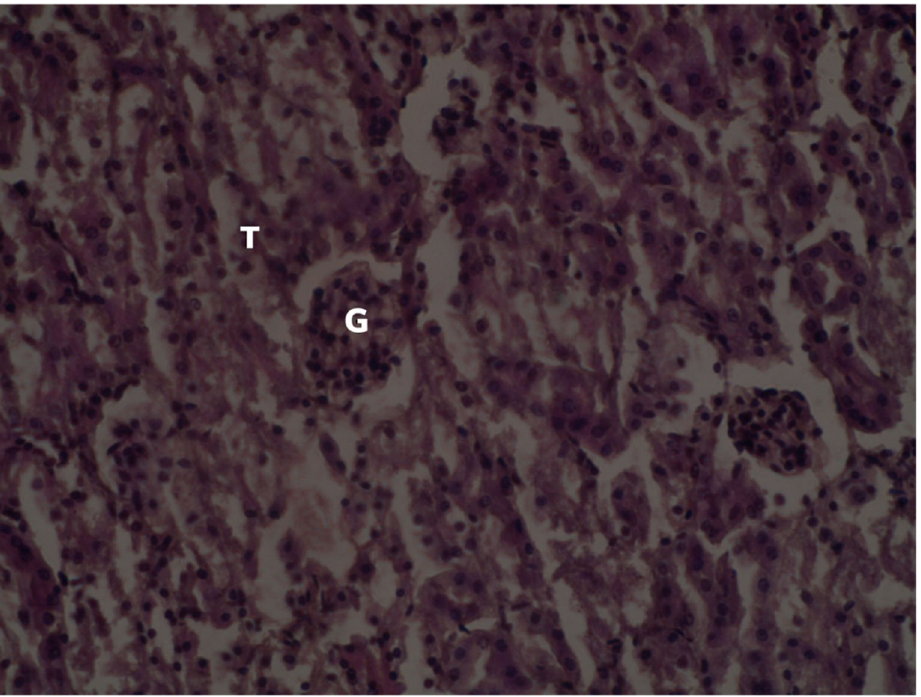
Figure 2. Normal renal parenchyma of the control group ( (cid:1) 400). No adjustments in terms of contrast or brightness. T: Renal tubules G: Glomerulus